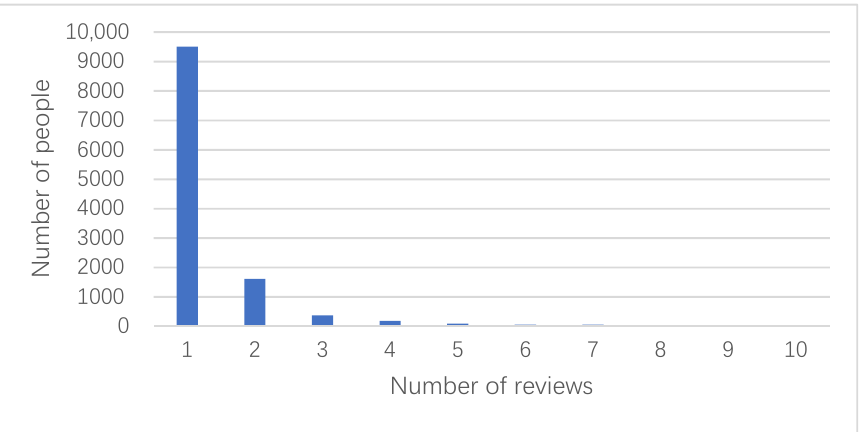
Figure 5. Statistics of the number of user reviews.